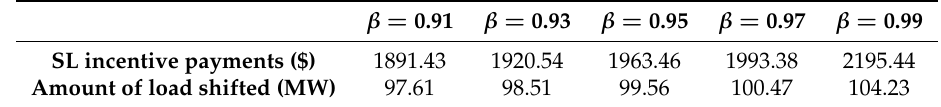
Figure 5. ( a ) Shiftable load (SL) incentive prices under different confidence levels ( b ) Customers’ demand under different confidence levels. Table 4. SL incentive payments of the retailer and the amount of customers’ shifted load under different confidence